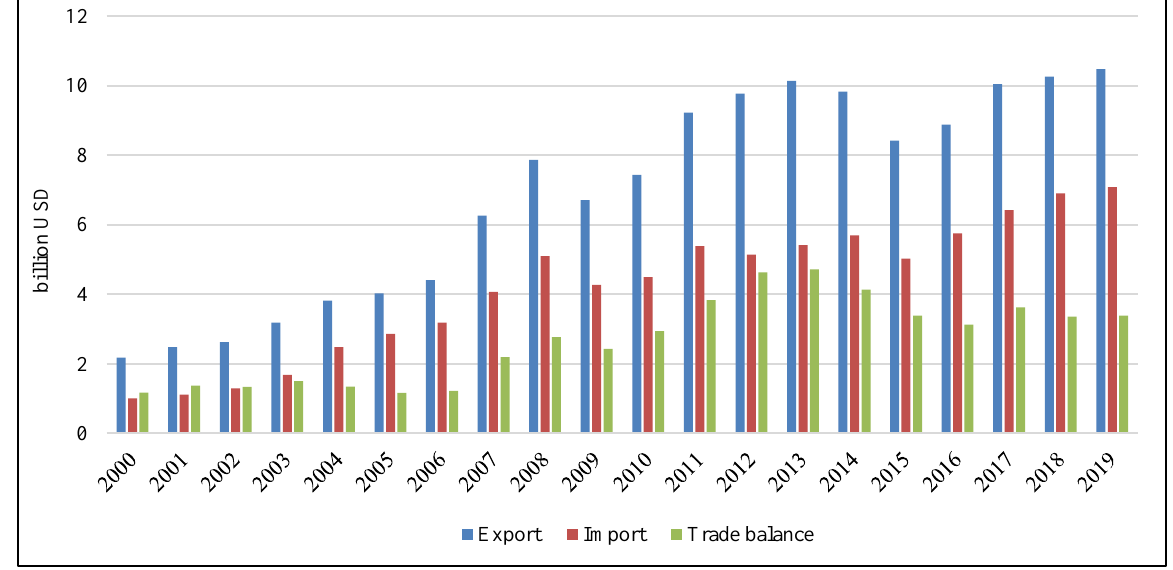
Figure 6. Hungarian agri-food exports, imports, and trade balance in billion USD, 2000-2019; Source: Author’s composition based on WITS [18]